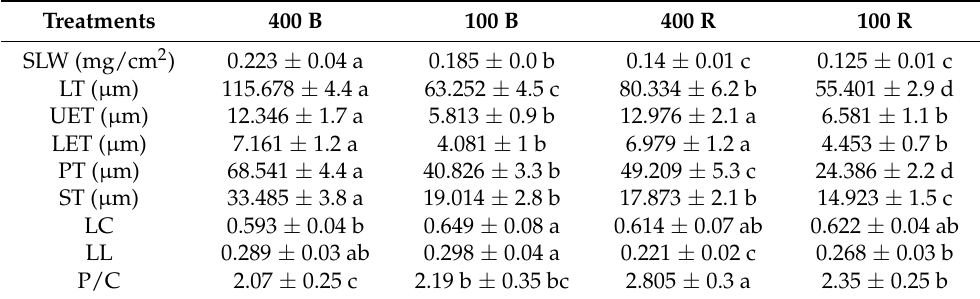
Table 1. Soybean leaf structure under different light intensities of blue and red light: 400 B and 100 B denote the blue light with 400 µ mol m − 2 s − 1 and 100 µ mol m − 2 s − 1 , respectively. 400 R and 100 R denote the red light with 400 µ mol m − 2 s − 1 and 100 µ mol m − 2 s − 1 , respectively. Treatments 400 B 100 B